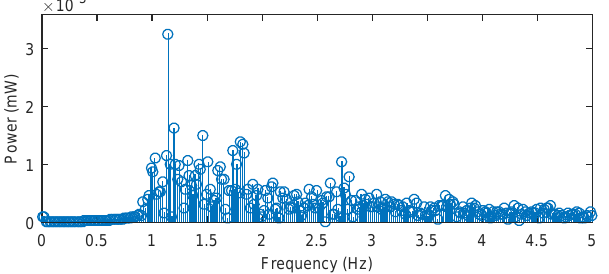
Figure 11. The frequency spectrum of pulsed pressure filtered signal (for heart rate calculation) in subject M1.